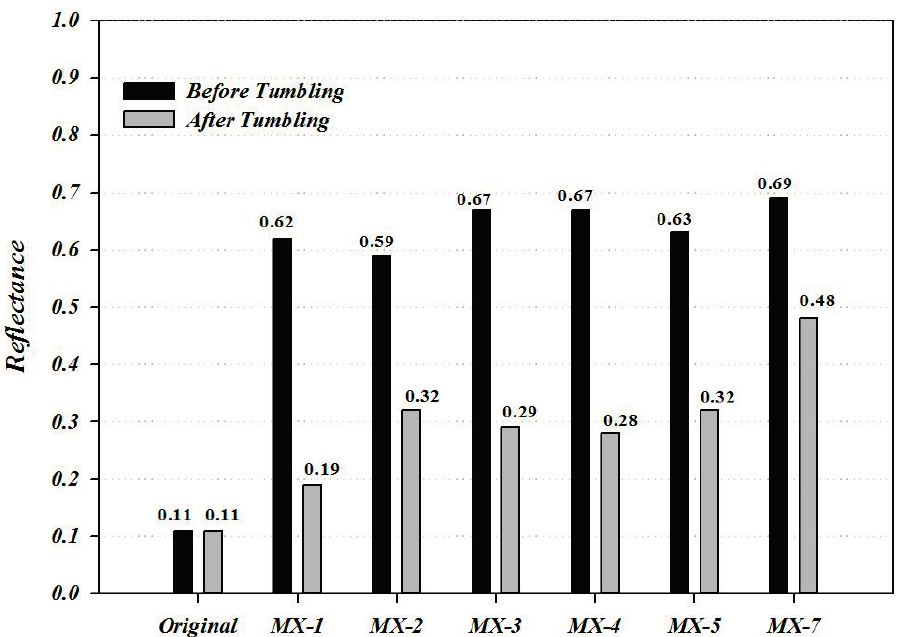
Figure 6. Reflectance measurements (average) of coarse size fraction of basaltic waste-rock before and after